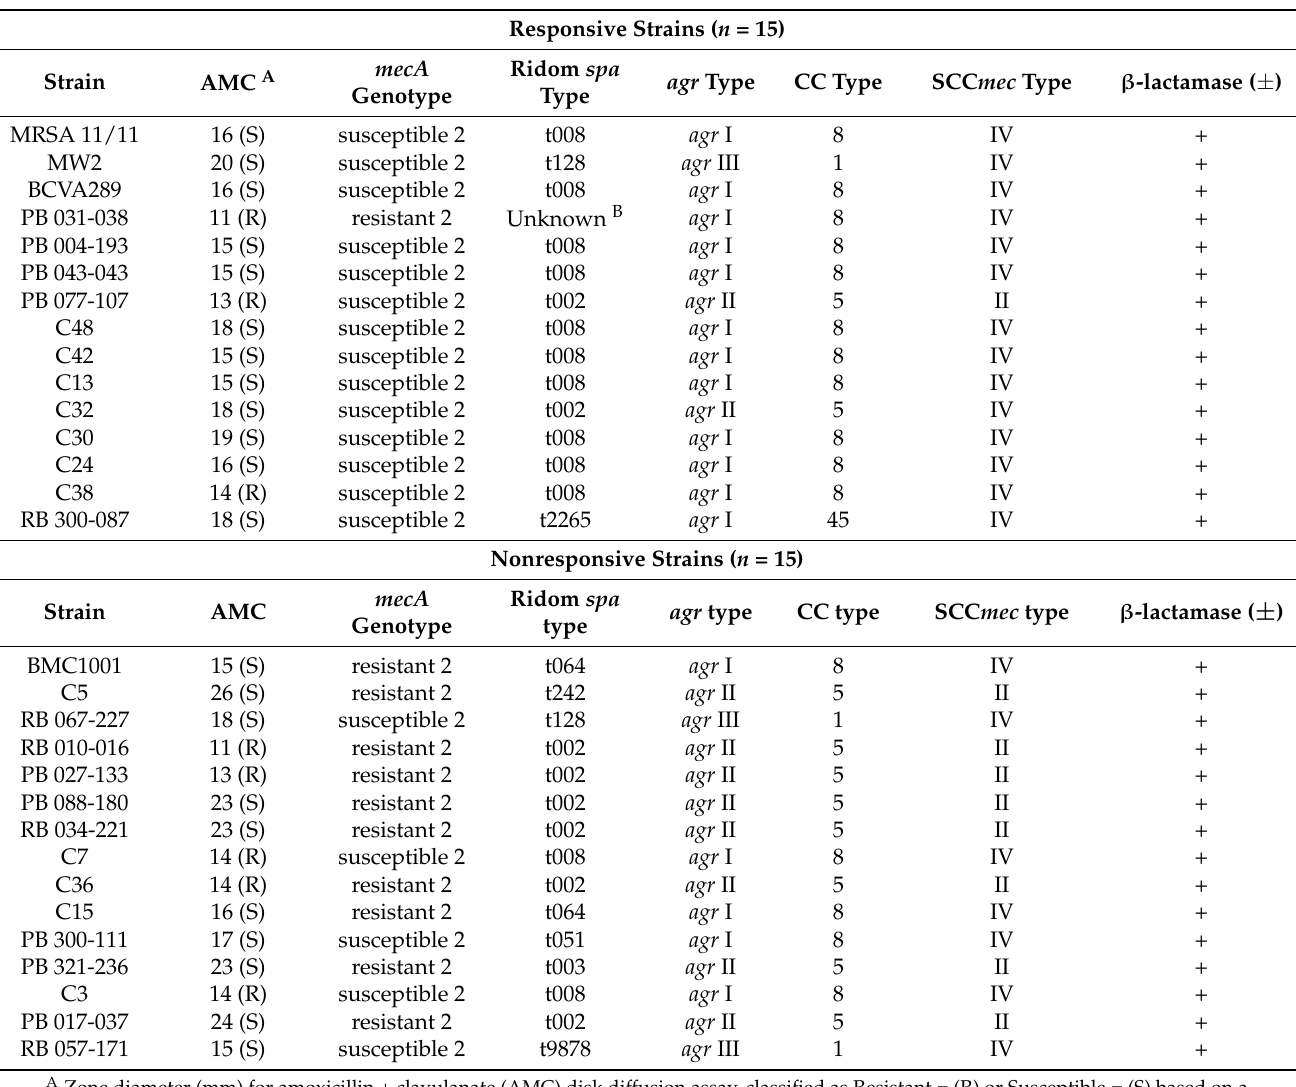
Table 1. Disk diffusion susceptibility to β -lactam/ β -lactamase inhibitors and genotypes for various loci in NaHCO 3 - responsive and nonresponsive MRSA